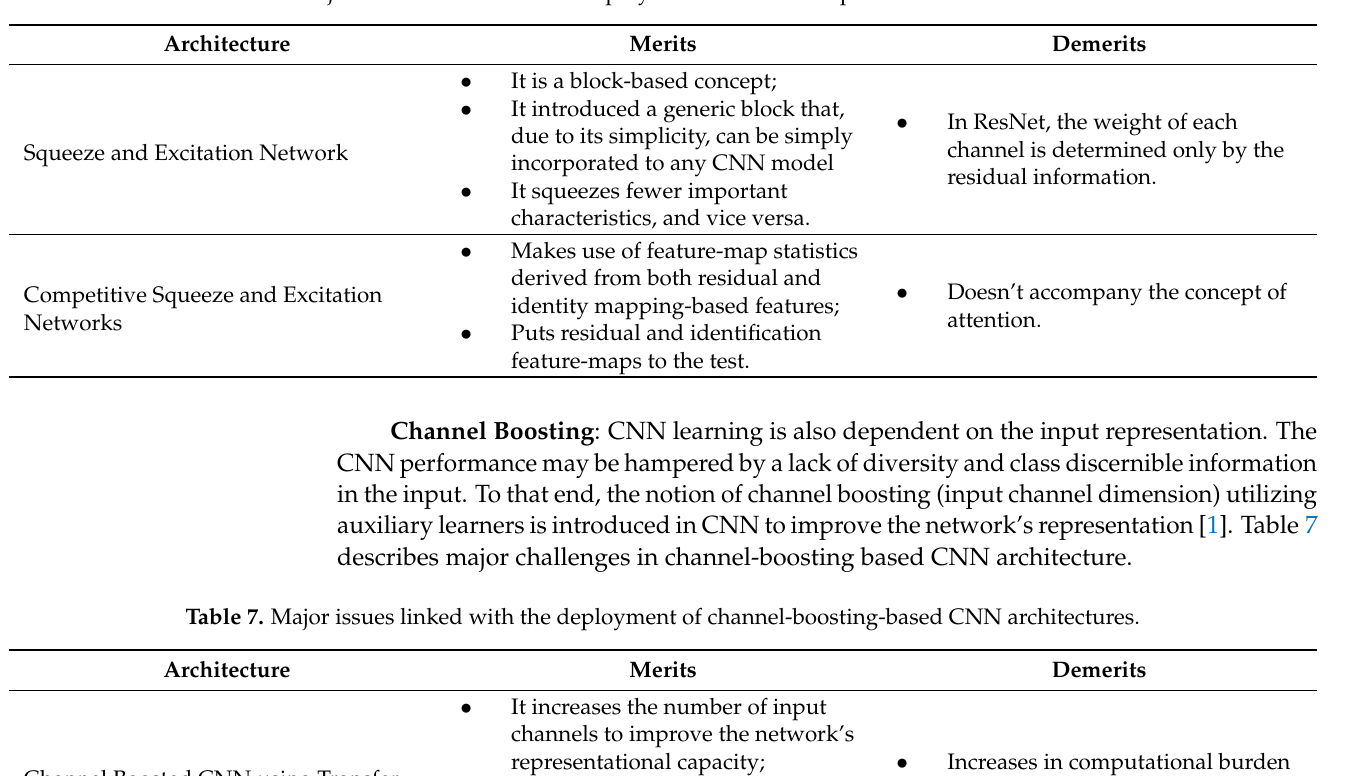
Table 6. Major issues linked with the deployment of feature-map-based CNN architectures.